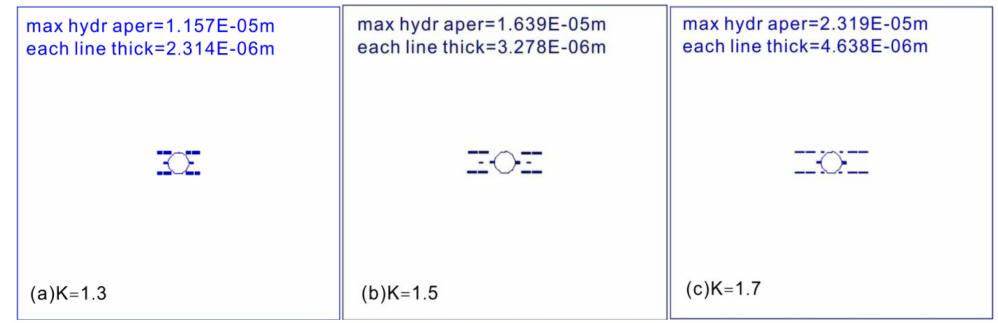
Figure 15. The relationship between hydraulic fracture geometry and stress ratio. ( a ) K = 1.3; ( b ) K = 1.5; ( c ) K = 1.7.